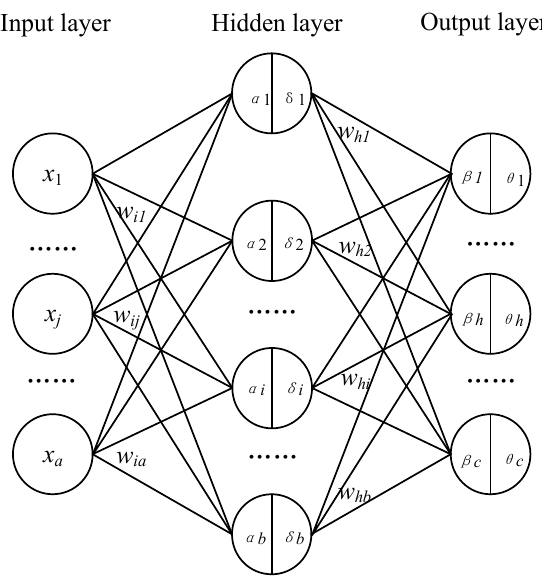
Figure 5. BP neural network with three layers.